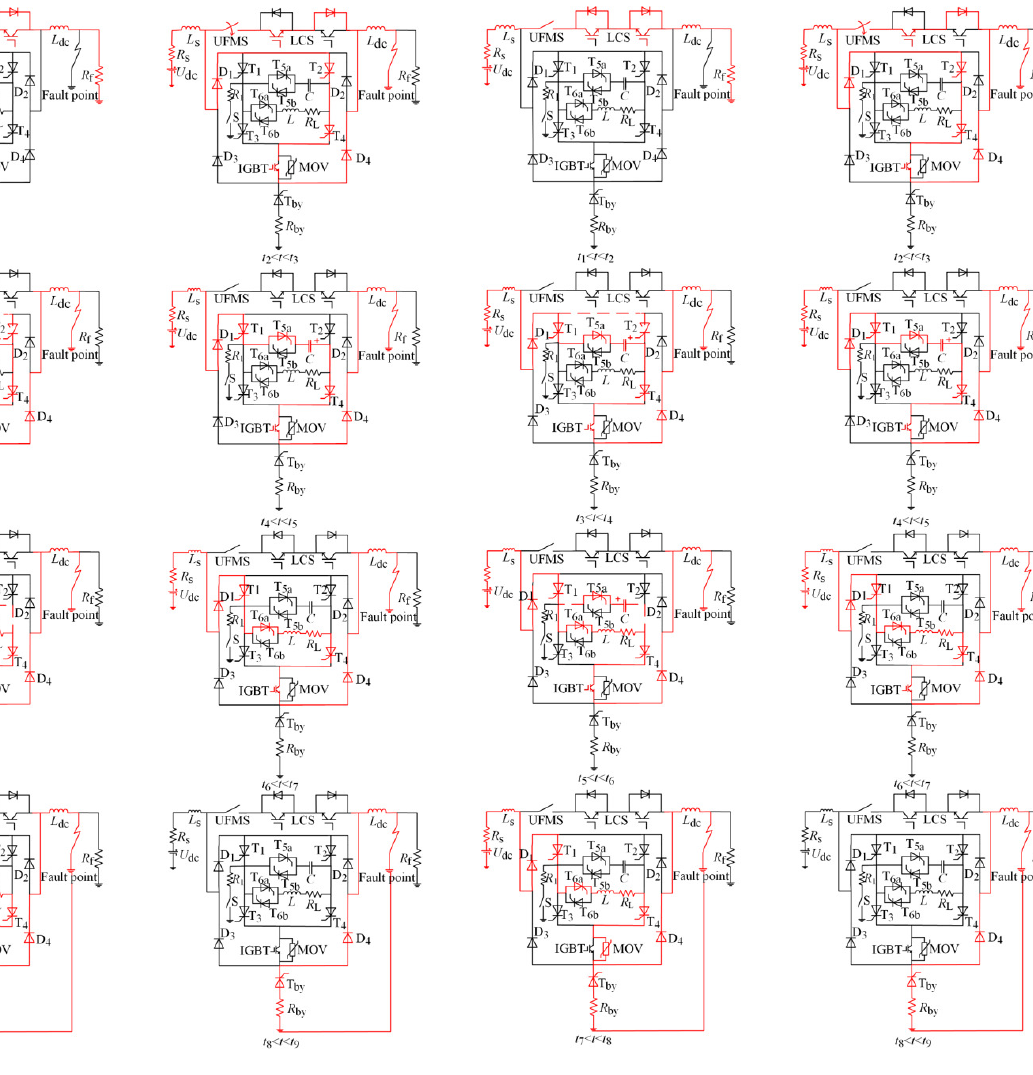
Fig. A.1. Fault shutdown path diagram Fig. A.2. Reclosing path